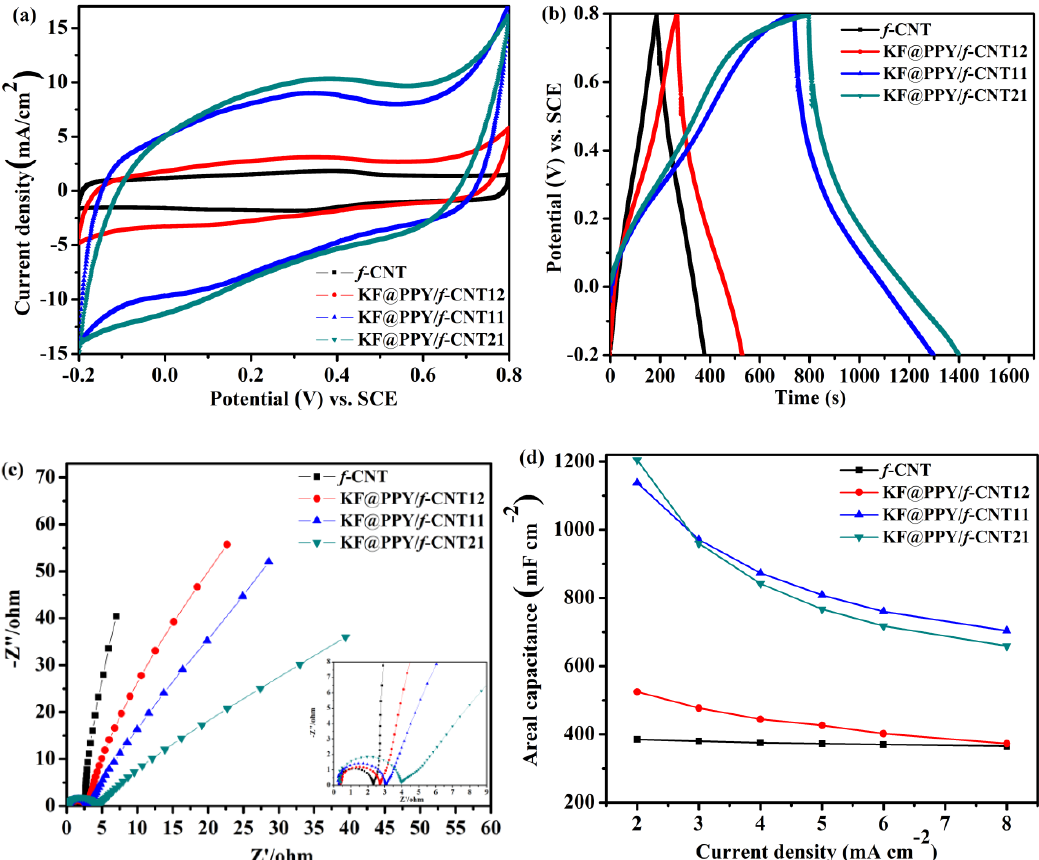
Figure 5. Electrochemical characterization of pure f -CNT and KF@PPy/ f -CNT freestanding hybrid electrodes prepared at various weight ratios (1:2, 1:1, 2:1): ( a ) cyclic voltammetry (CV) curves (scan